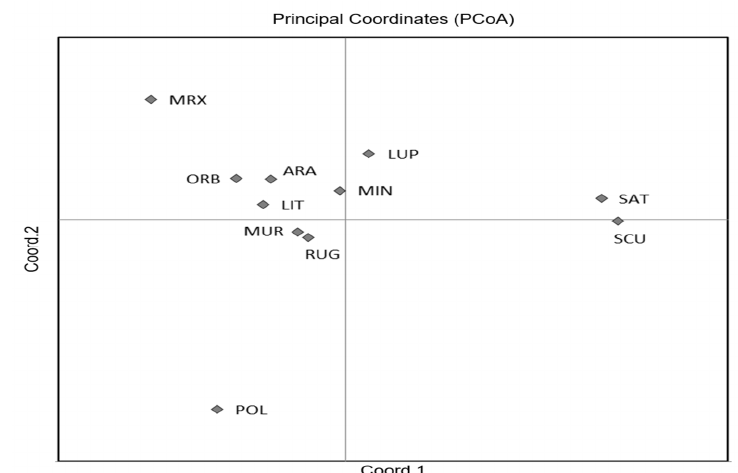
Figure 2. Plot of Principal Coordinate Analysis (PCoA) for the 11 Medicago species. Codes are as